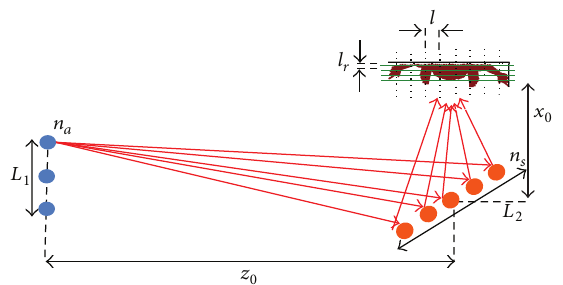
Figure 2: Top view of the radar configuration. The blue circles on the left represent a thinned array of transmitter/receiver antennas; the orange dots on the right represent the passive reflecting surfaces, which randomly redirect the energy of the radar towards the target; the person under test (target) is represented by the red silhouetteon thetop, and thetwo dimensional planes over which the reconstruction is implemented are represented by the green lines.